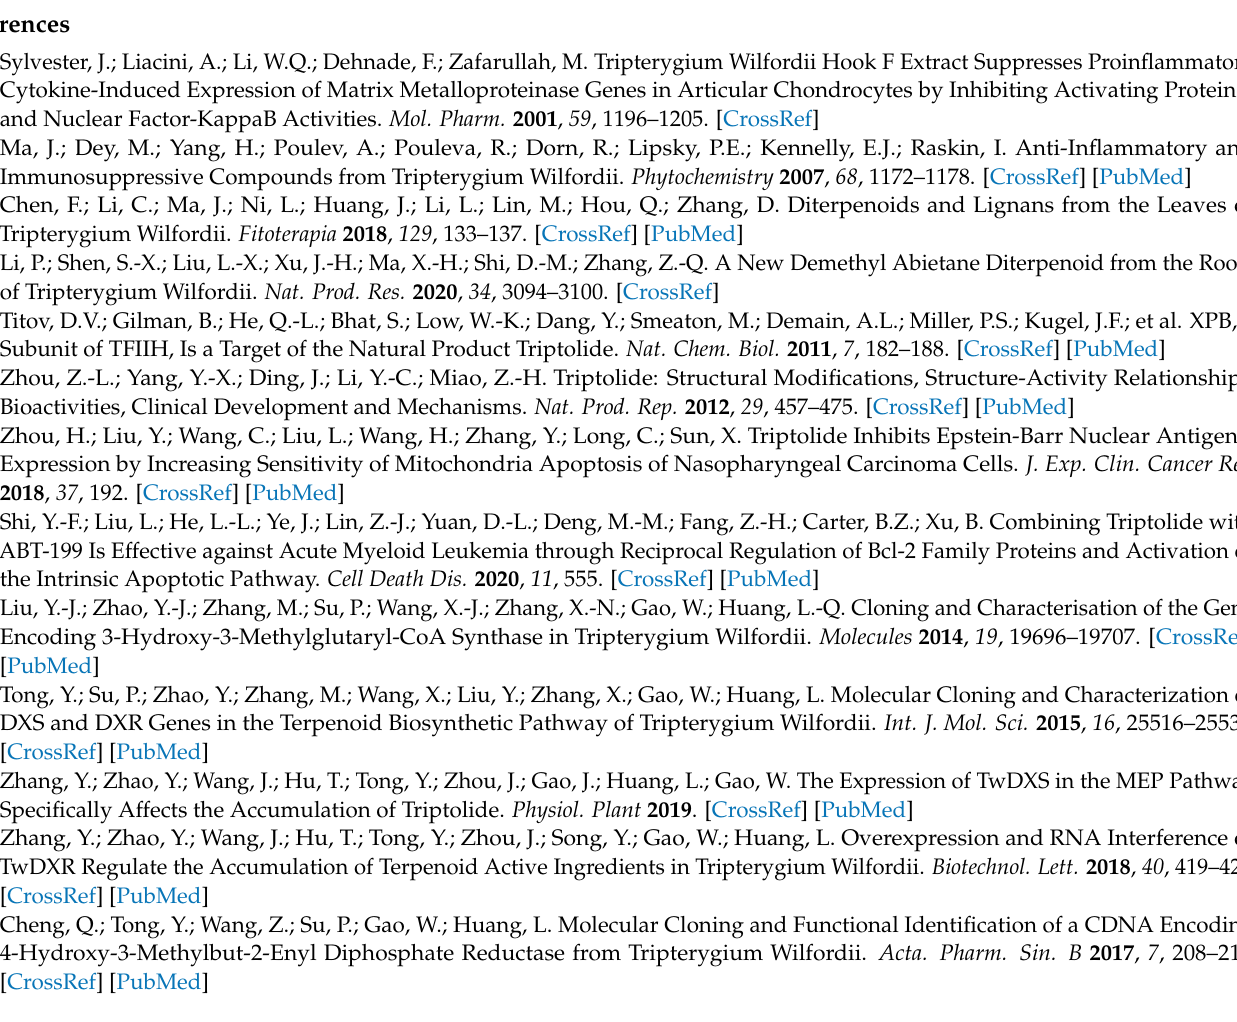
Table S7: Reaction procedures of FPNI-PCR, Figure S1: Cloning of the 5 (cid:48) -flanking sequences of TwTPS27a and TwTPS27b , Figure S2: Identification of the PCR products for the full-length coding sequence (CDS), gDNA and 5 (cid:48) /3 (cid:48) -RACE of TwTPS27a and TwTPS27b , Figure S3: The full-length CDSs and protein sequences alignment between TwTPS27a and TwTPS27b , Figure S4: Sequence alignment between the full-length CDS and gDNA of TwTPS27a , Figure S5: Sequence alignment between the full-length CDS and gDNA of TwTPS27b , Figure S6: Sequence alignment between 5 (cid:48) /3 (cid:48) -RACE sequences and CDSs of TwTPS27a/b , Figure S7: Sequence alignment for the determination of the TwTPS27a and TwTPS27b promoters. Figure S8: Sequence alignment between TwTPS27a promoter from − 1115 to +124 bp and TwTPS27b promoter from − 1088 to +124 bp, Figure S9: Verification of various promoter::GUS vectors, Figure S10: Primers designed for cloning the CDSs and gDNA sequences of TwTPS27a/b